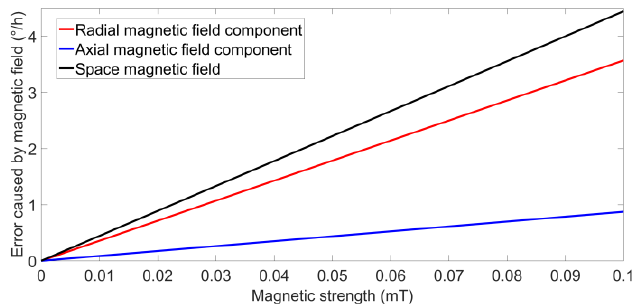
Figure 6. Simulation results of magnetic-induced errors caused by space magnetic fields.